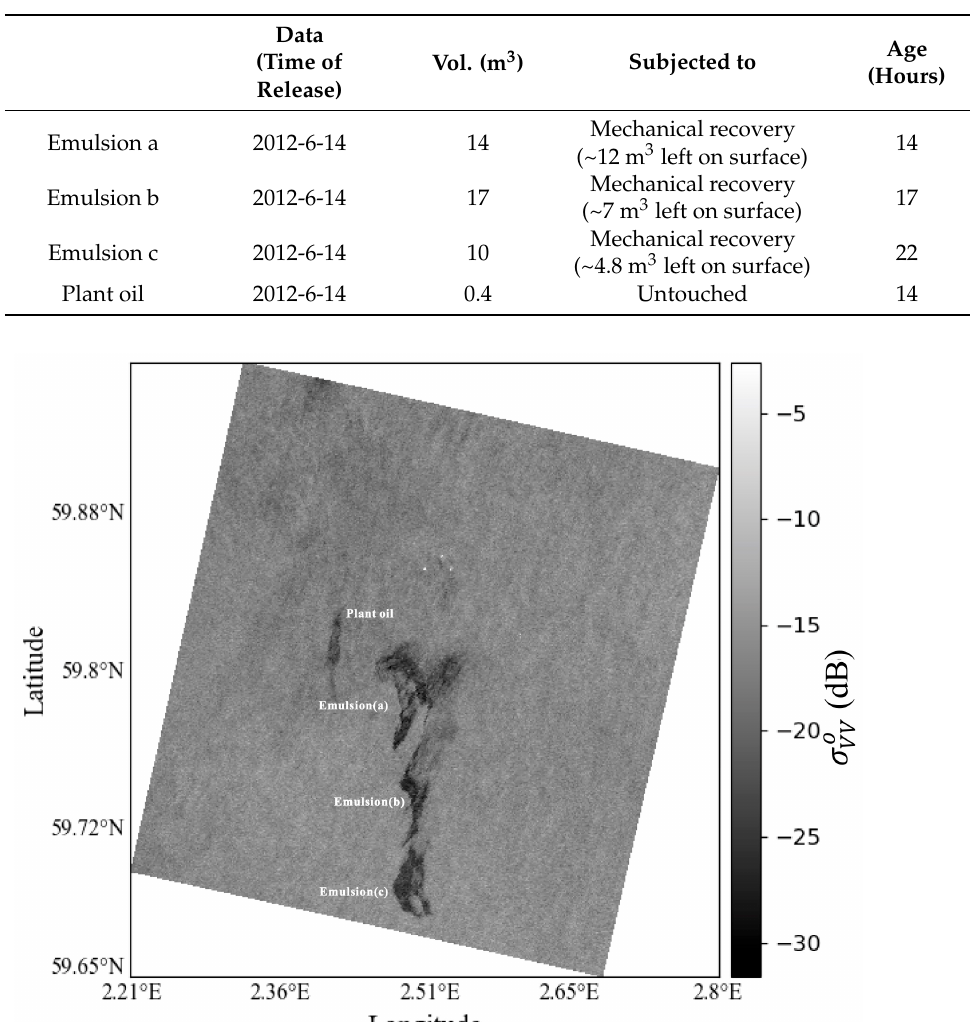
Table 2. Detailed material information for Case 3 [25].